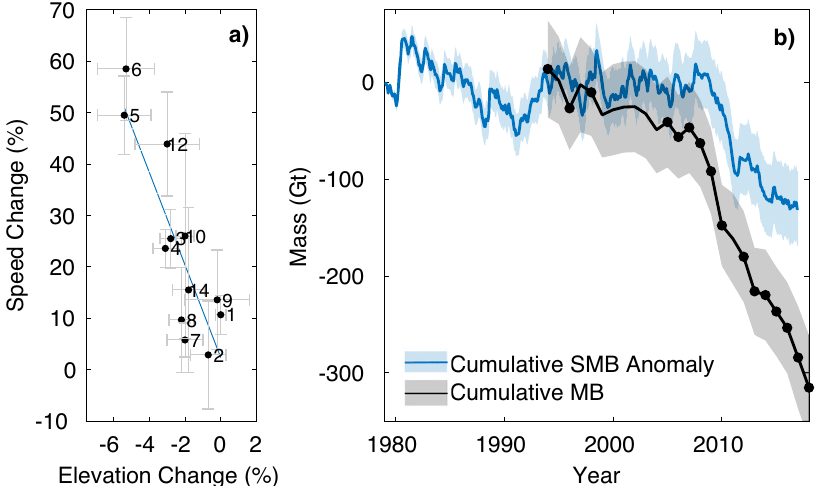
Fig. 3 Ice dynamic relationship and mass balance. a Total change in speed since 1994 as a percentage of 2018 velocity, scattered against change in ice thickness as a proportion of the total ice thickness. The number of each fl ow unit is annotated on each point, and the linear relationship (blue dashed line) between the two variables has an R 2 value of 0.74. Flow units 11 and 13 excluded due to low coverage of the velocity observations (<70%) in the 5 km region at the grounding line. The uncertainty bars (grey) are the standard deviation of the values extracted within the 5 km buffer region for each glacier. b The Cumulative Mass Balance from the Getz drainage basin between 1994 and 2018 (black line), fi lled black circles represent years with velocity observations, along with the cumulative Surface Mass Balance (SMB) anomaly from 1979 to 2016 (blue line) 68 . The mass balance uncertainty is calculated as the discharge error combined with the error in SMB. Discharge error is the combination of the percentage errors in ice thickness and velocity along the fl ux gate. For years of model discharge without a corresponding observation map, we assume the percentage error of the nearest observation year and add an additional standard deviation to the velocity error. We assume the uncertainty in the annual SMB trend to be 20% in line with previous studies 23,69 and the cumulative uncertainty is the root sum square of the annual errors, assuming that they are not correlated over